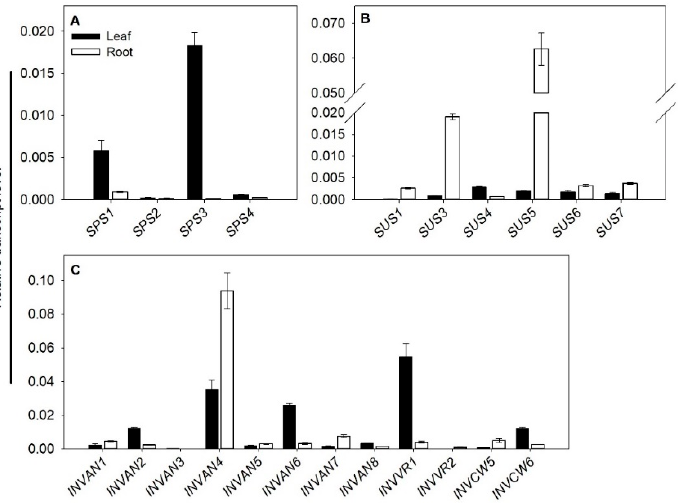
Figure 7. Expression of SPS , SUS and INV genes in leaves and roots of tomato. Expression was monitored using quantitative RT ‐ PCR at three ‐ leaf stage. ( A ) SPS expression; ( B ) SUS expression; ( C ) INV expression.